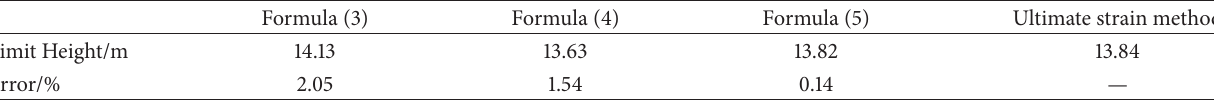
Table 2: Contrast of limit heights from different